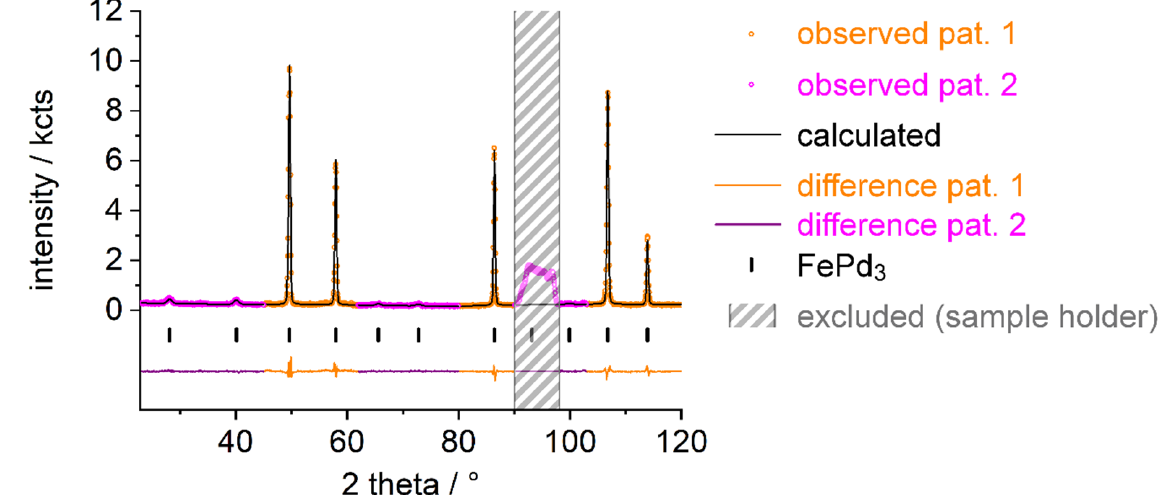
Figure A16. Rietveld refinement of the crystal structure of FePd 3 D 0.051(9) (for details, see fourth row in Tables A8 and A9) based on neutron powder diffraction data (NUMOR 131765 [21], λ = 186.80(2) pm, D20 ILL, Grenoble) in a single-crystal sapphire cell at 376(3) K and 8.10(1) MPa deuterium pressure using FullProf [24].